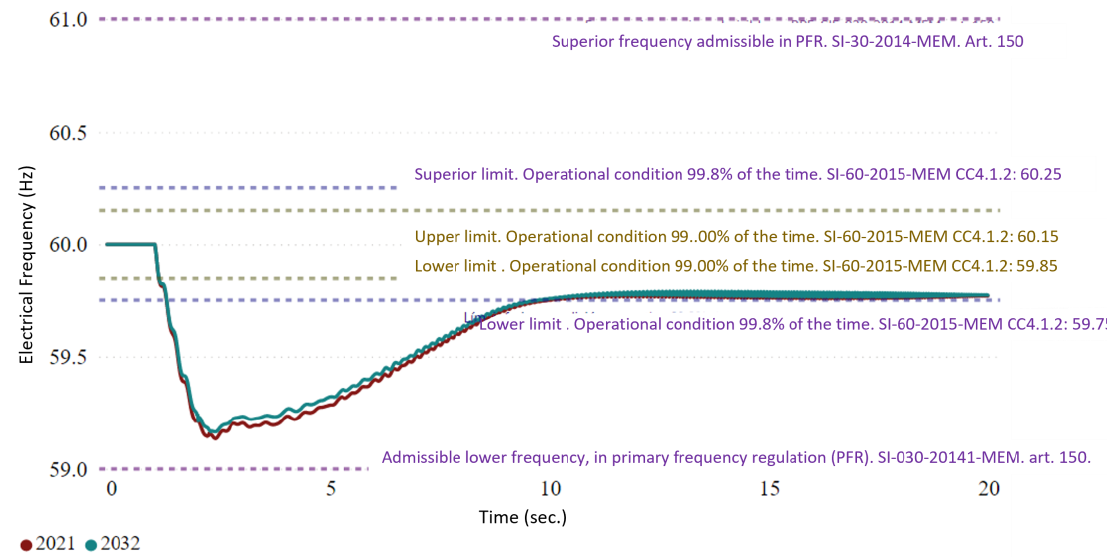
Figure 10. Electric frequency comparison slack bus between the years 2021 and 2032.